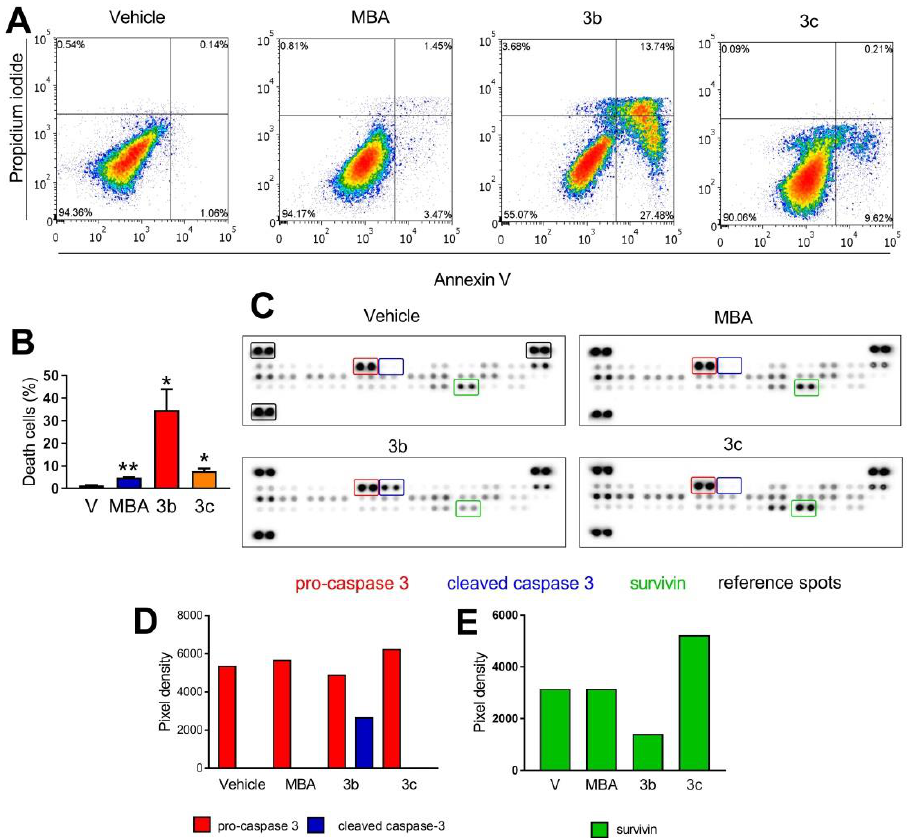
Figure 3. Effect of MBA and derivatives 3b and 3c on apoptisis in HCT-116 cell line after 24 h exposure at 20 µ M. ( A ) representative cytograms (with percentage of cells in each quadrant) from one of at least two independent experiments are shown, ( B ) quantification of cell death as a sum of both annexin+/PI − and annexin+/PI+ cells, ( C ) changes in apoptosis-related proteins determined with using a Human Apoptosis Proteome Profiler kit. ( D ) quantification of changes of expression of pro-caspase-3 and cleaved caspase-3, ( E ) quantification of changes of expression of survivin; * p < 0.05, ** p < 0.005.